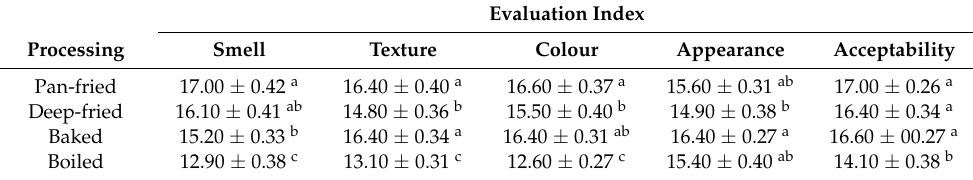
Figure 1. Radar Chart of Sensory Score of BTS meat under Different Processing Methods. Table 1. Analysis of Sensory Assessment Data of BTS meat under Different Processing Methods.